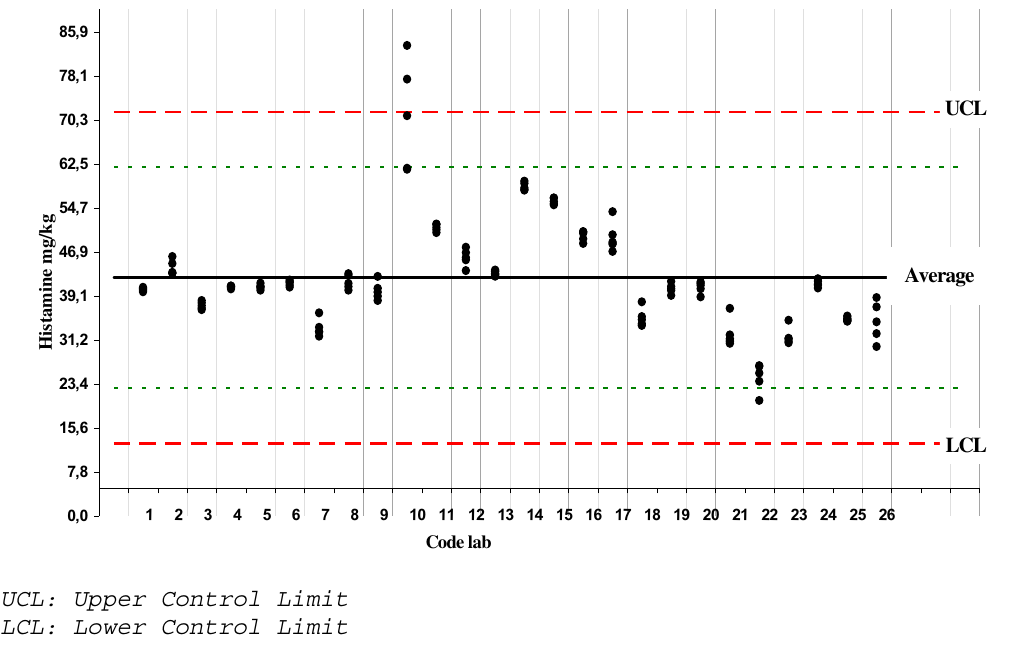
Fig. 2. (Color online) Histamine (mg/kg), in the level 1 matrix obtained by the 26 participating